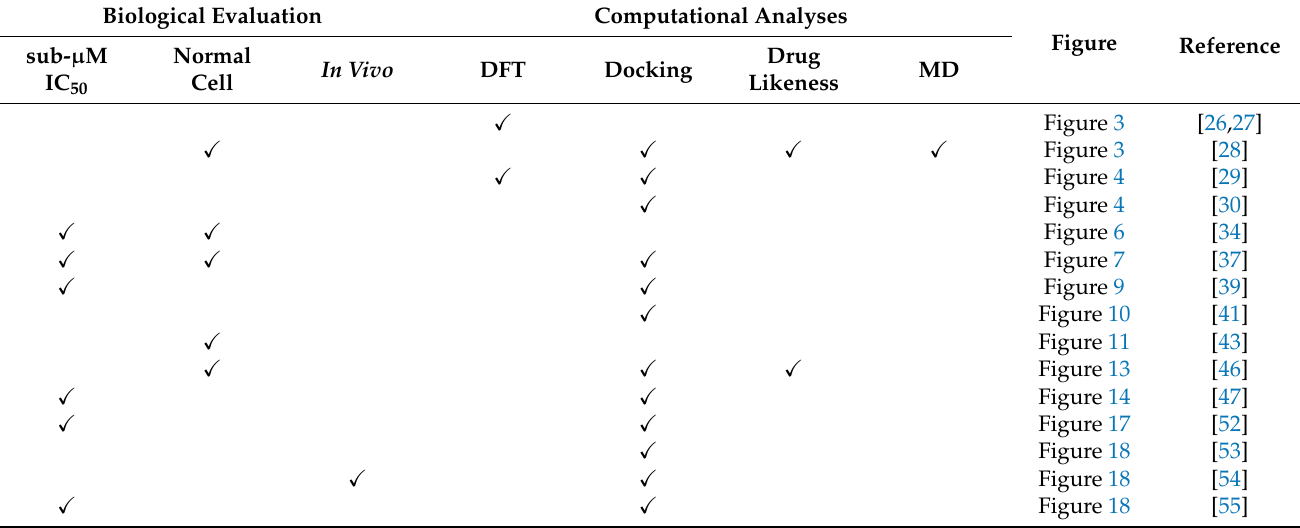
Table 1. Summary of data reported in the reviewed works on biological evaluation and computa- tional analyses.